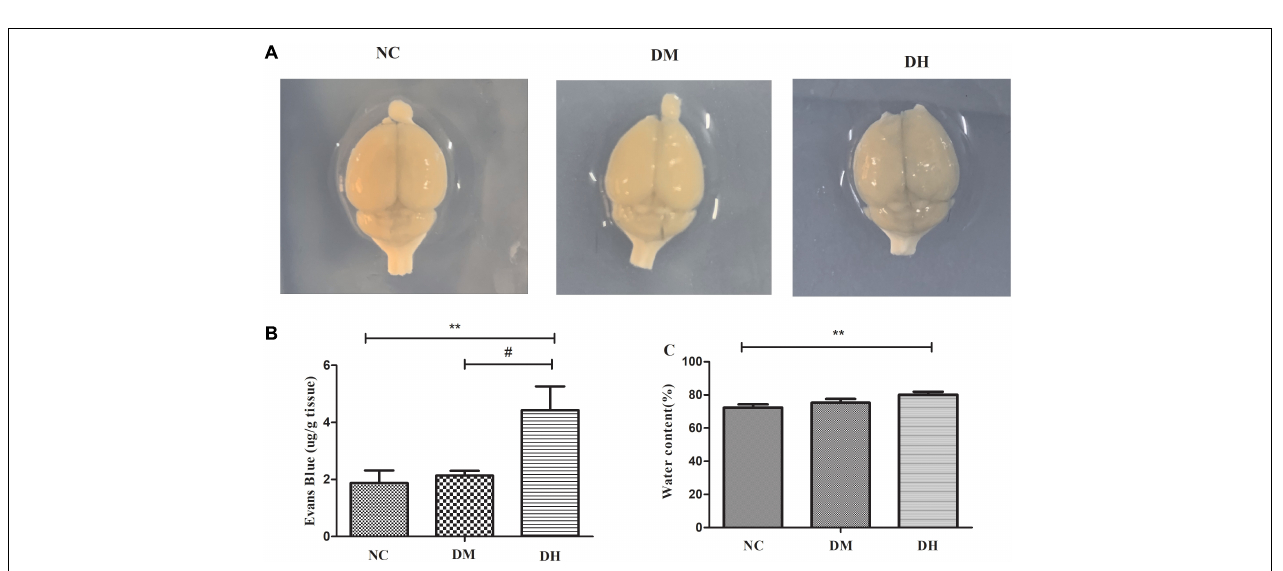
FIGURE 6 | Effects of severe hypoglycemia on BBB and brain edema. (A) Naked-eye view of Evans blue exocytosis in mouse brain. (B) Quantification of Evans blue extravasation. (C) Mouse brain water content. N = 3 per group. Data are the means ± SEM. ** P < 0.01 NC vs. DH, & P < 0.05 NC vs. DM, # P < 0.05 DM vs. DH.